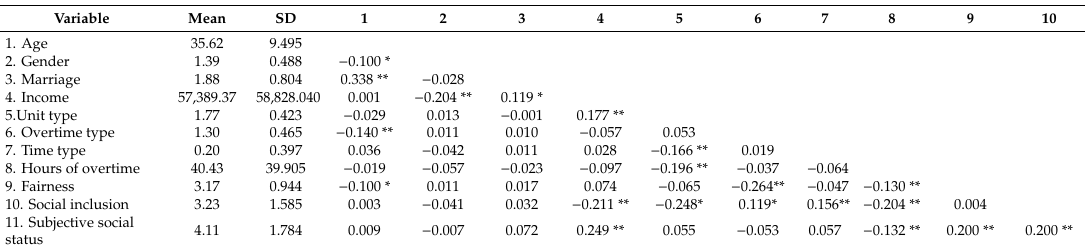
Table 2. Standard Deviations and Correlations Among Study